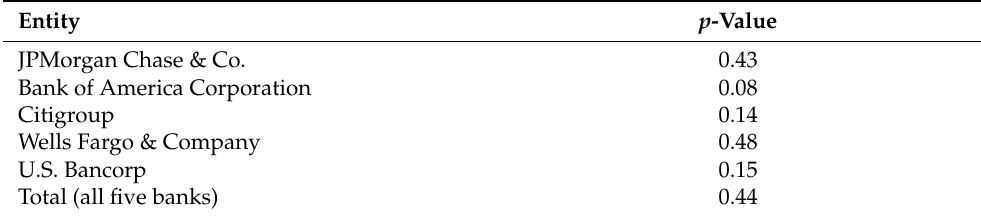
Table 7. Kolmogorov–Smirnov test